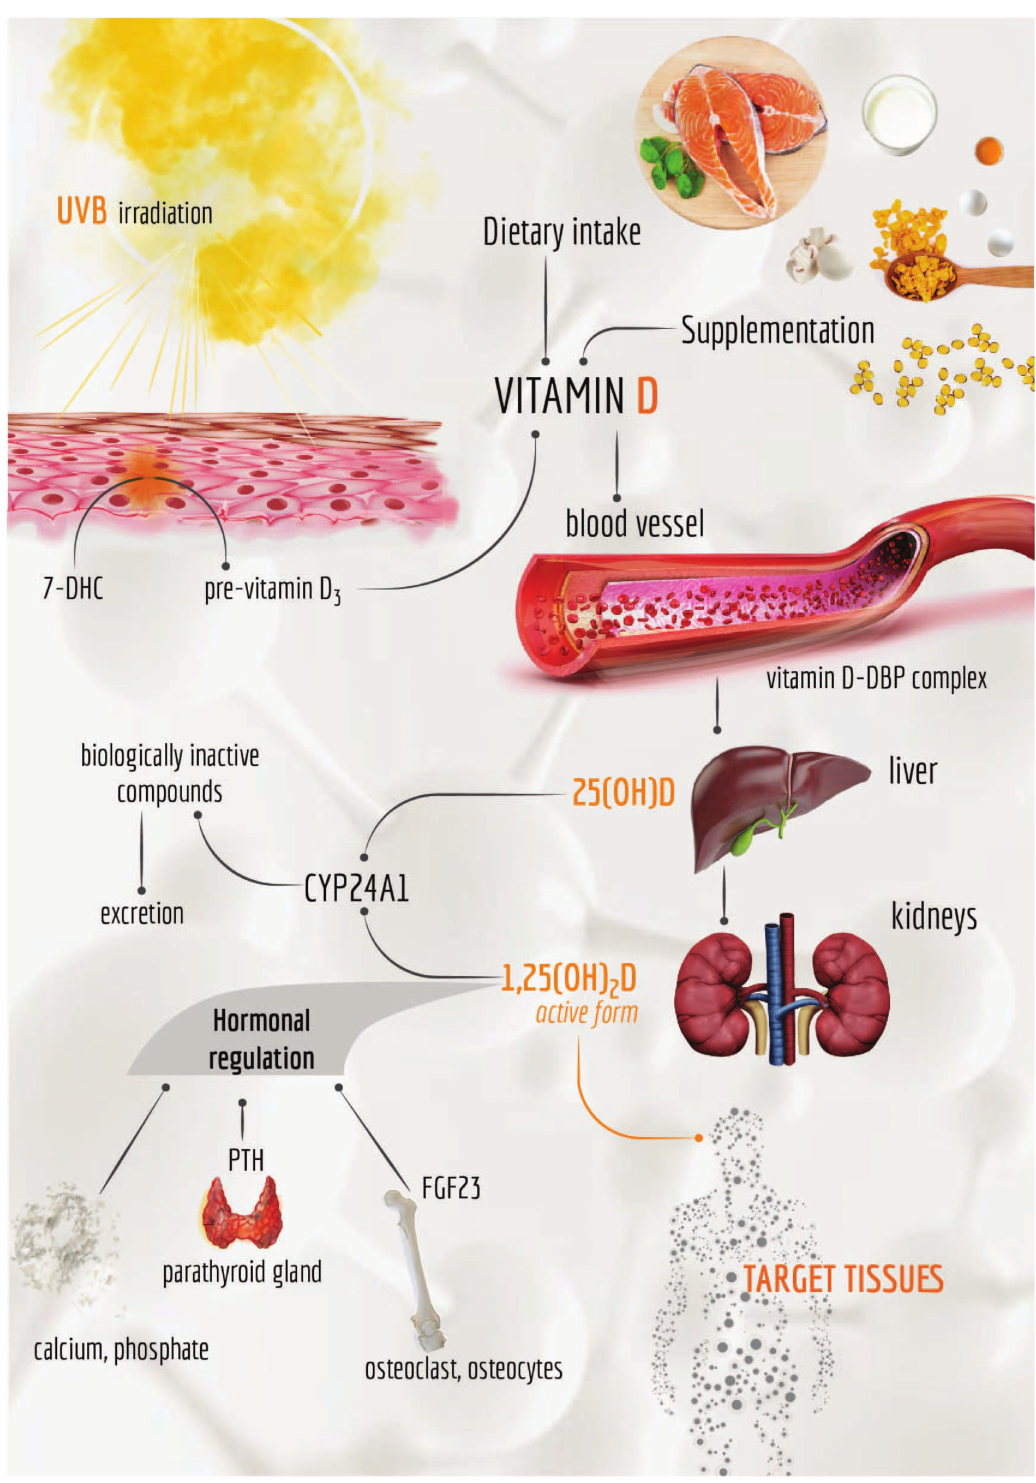
Figure 2. Schematic representation of the synthesis and metabolism of vitamin D. The main sources of vitamin D, i.e., supplementation, UV exposure and dietary intake are highlighted. A detailed description of the production of the active form, 1,25(OH) 2 D, and the regulation of its amount is also illustrated. UVB: ultraviolet B; 7-DHC: 7-dehydrocholesterol; DBP: vitamin D binding protein; PTH: parathyroid hormone; FGF23: fibroblast growth factor. Figure was redrawn from Szymczak-Pajor et al.